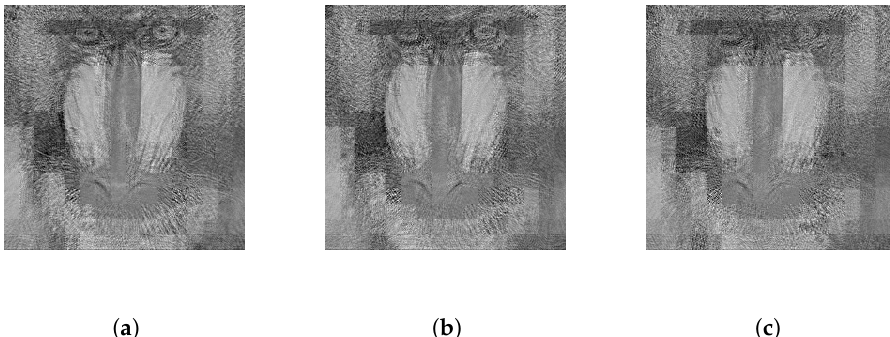
Figure 10. The decrypted image of a baboon transmitted by the channel containing AWGN with zero-mean and a standard deviation of ( a ) 40, ( b ) 60, or ( c )